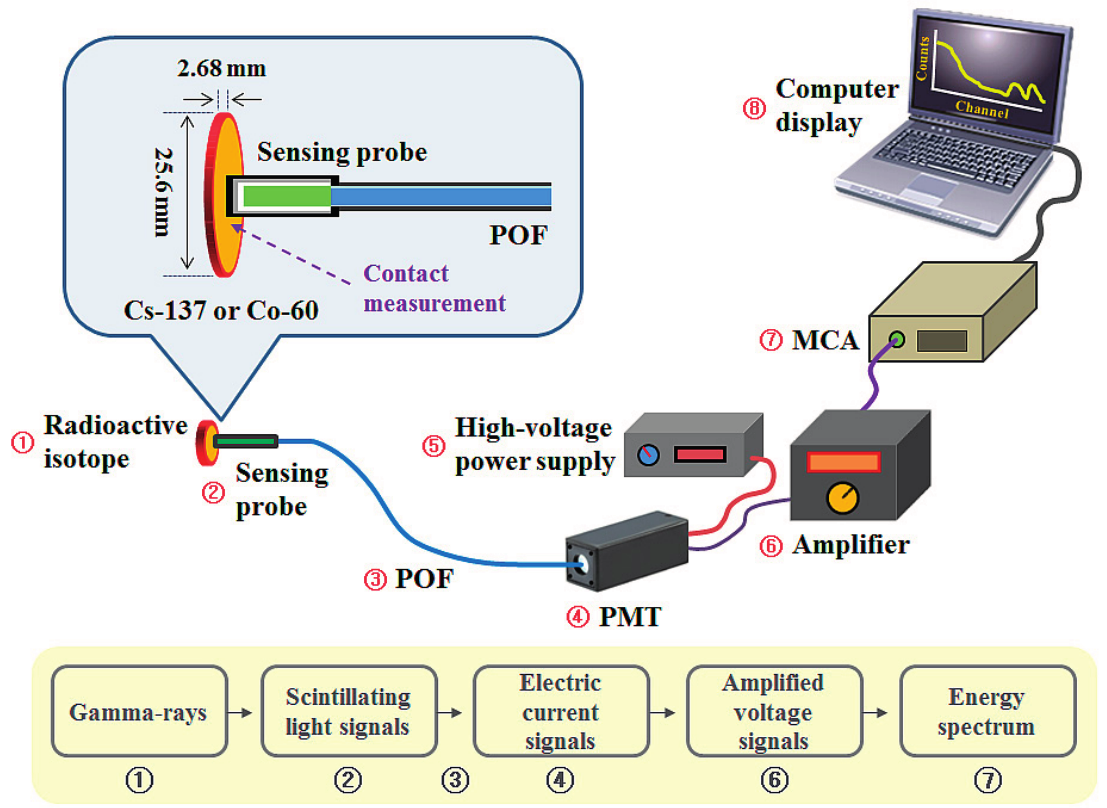
Figure 2. Experimental setup for measuring gamma-ray energy spectra using a FORS and gamma-ray